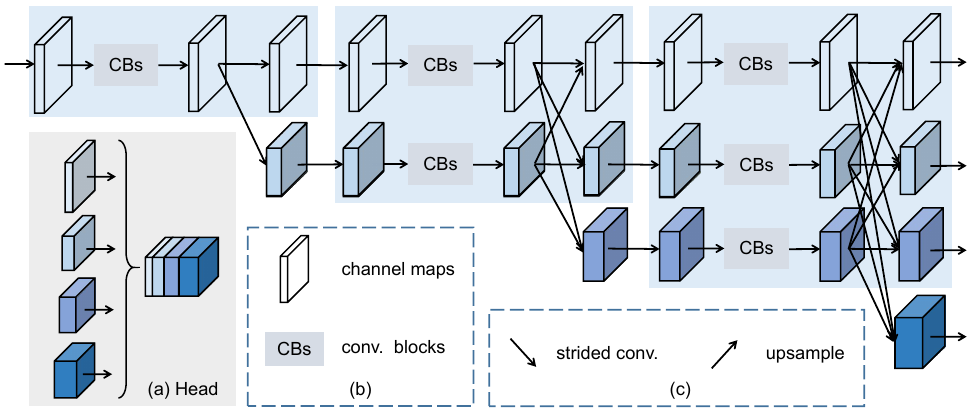
Figure 2. Illustration of the main structure in our HRNet. The 1st stage (light blue box) only has the high-resolution branch, while the 2nd (3rd) stage contains two-resolution (three-resolution)